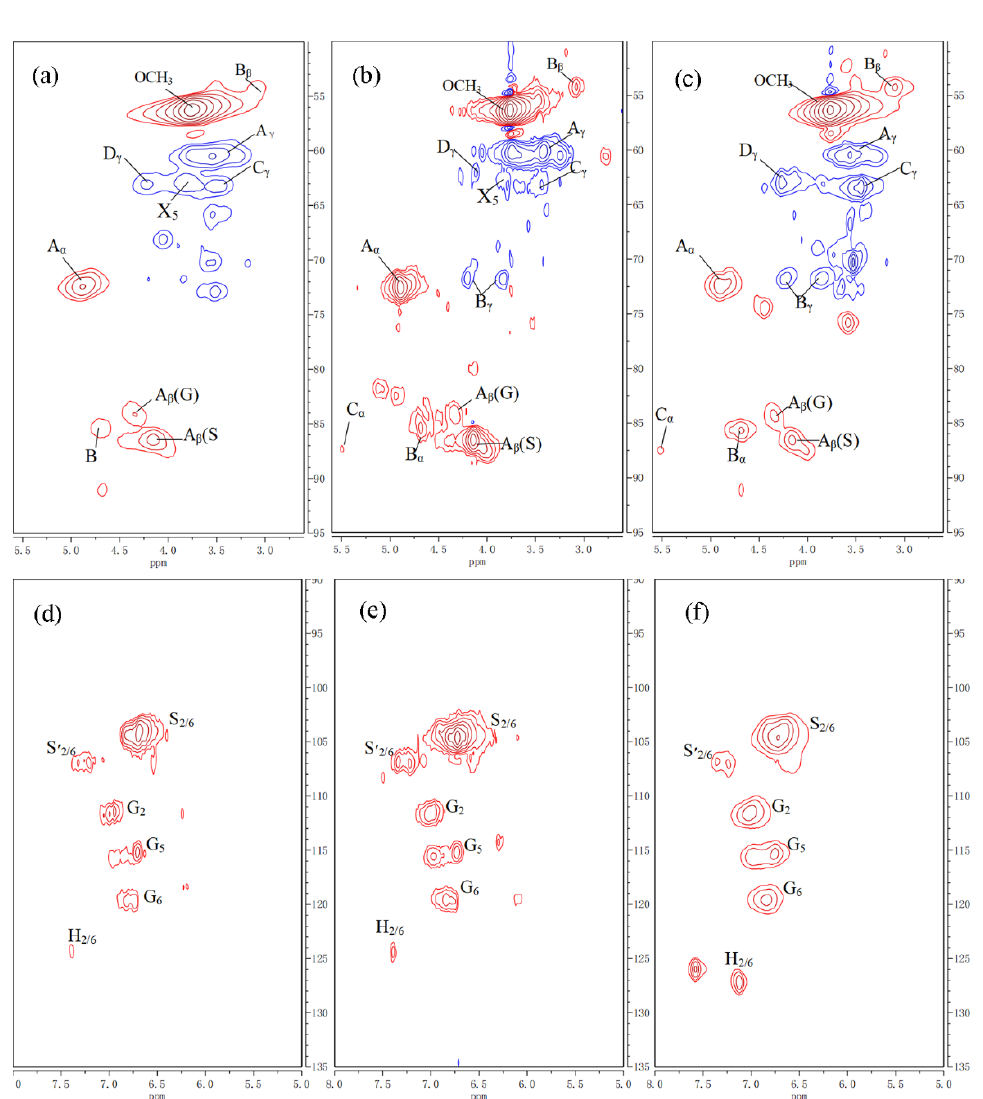
Figure 3. Aliphatic region in the 2D NMR spectrum of lignin from ( a ) raw jute fibers, ( b ) jute fibers pretreated at 100 °C for 5 h and ( c ) jute fibers pretreated at 130 °C for 5 h; aromatic region in the 2D NMR spectrum of lignin from ( d ) raw jute fibers, ( e ) jute fibers pretreated at 100 °C or 5 h and ( f ) jute fibers pretreated at 130 °C or 5 h.